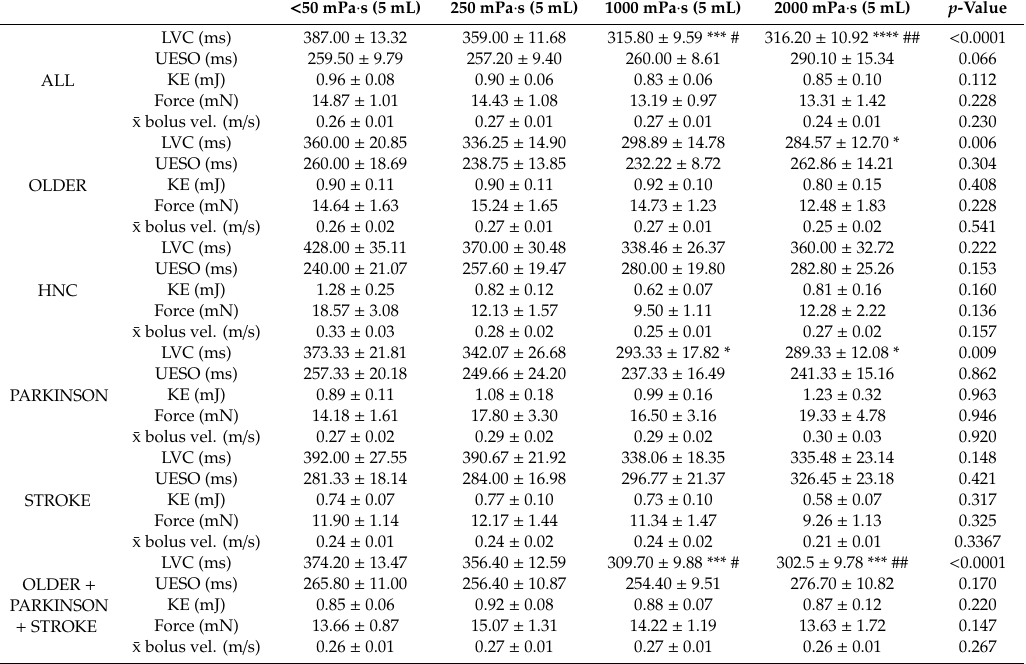
Table 3. Comparison between viscosities of oropharyngeal swallow response among the study groups (continuous variables expressed as mean ±